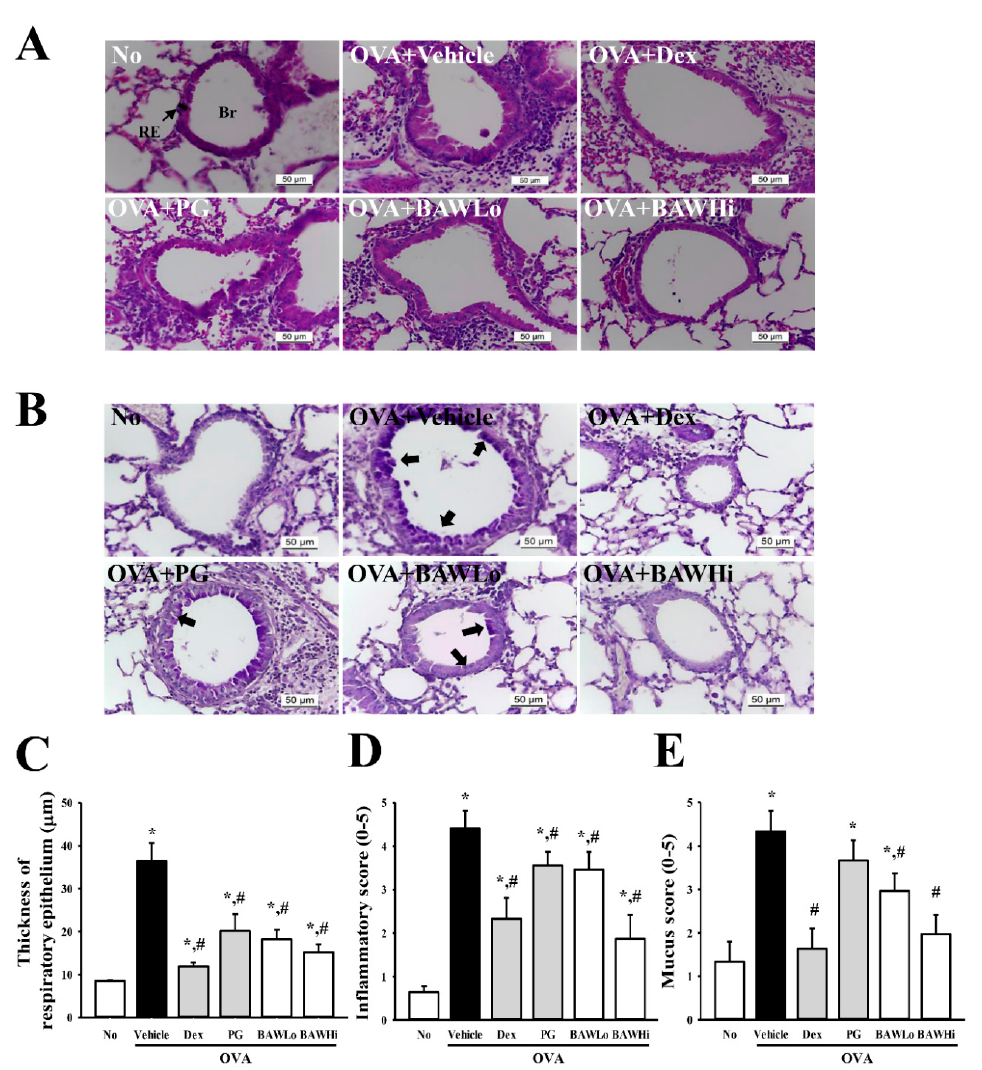
Figure 4. Histopathology in lung tissue of OVA-induced asthma model. ( A ) Histological alteration of lung tissue. The epithelial thickness and infiltration of inflammatory cells in the peribronchiolar region were observed in lung tissue stained with H&E solution at 400 × magnification. ( B ) Goblet cell hyperplasia. Mucus production was observed in Periodic acid–Schiff (PAS) stained lung tissue at 400× magnification. ( C ) Quantification of epithelial thickness. Alterations in epithelial thickness of lung tissue were measured using the Leica Application Suite. ( D ) Inflammatory infiltration score of airway.